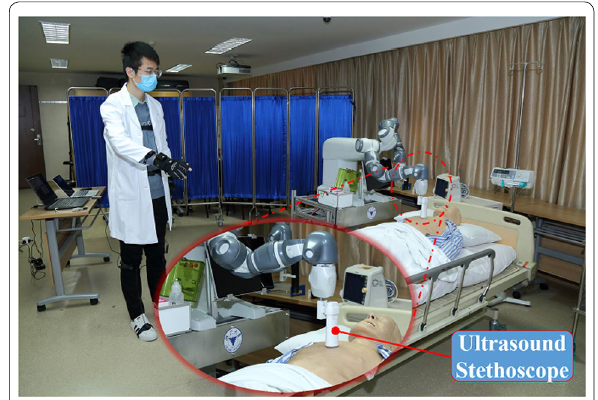
Figure 5 Remote operation of the medical instruments using the teleoperated